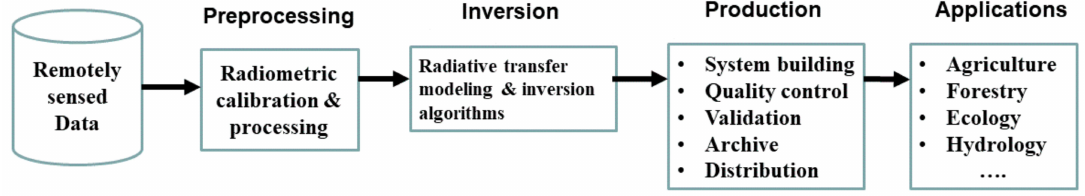
Figure 1. The scope of quantitative land remote